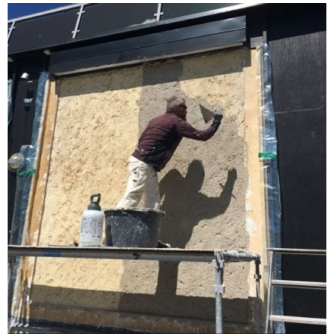
Figure 8. Applying a lime render to one section of the hemp-lime façade.